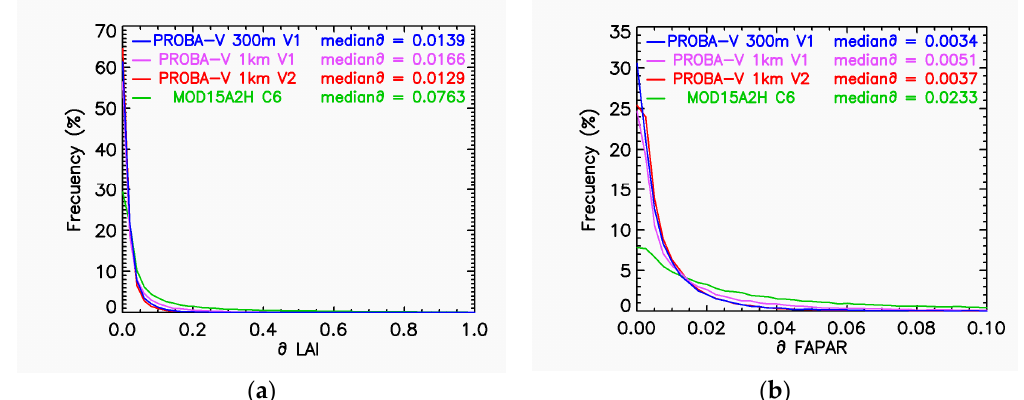
Figure 6. Histograms of the delta function for LAI ( a ), and fAPAR ( b ) by the PROBA ‐ V Collection 300 m V1 (blue), PROBA ‐ V Collection 1 km V1 (purple), PROBA ‐ V Collection 1 km V2 (red) and MODIS C6 (green) products over LANDVAL sites from 2016 to 2017.